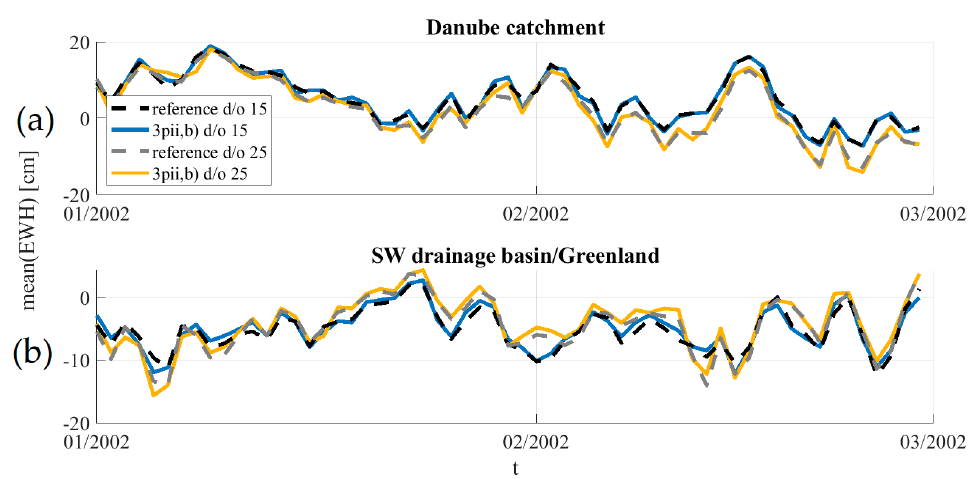
Figure 12. Time series in EWH (cm) for Danube catchment (a) and SW drainage basin in Greenland (b) of Scenario 3pii,b extracted from daily solutions with d/o 15 and 25. Two-month period extracted from the one year processed.